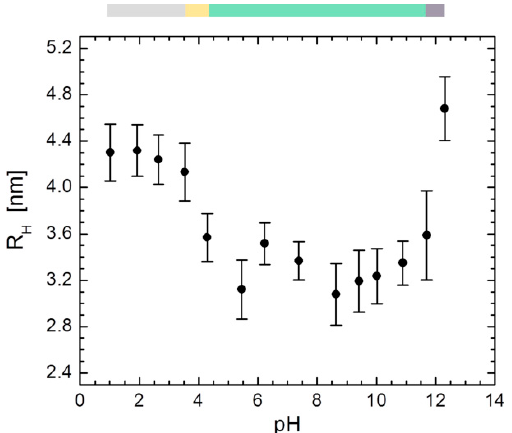
Figure 10. pH ‐ dependent DLS experiments on pure HSA. Hydrodynamic radii R H of HSA are given as a function of pH. The phase space bar gives the extended form (E, gray), compact form (C, green) and the aged form (A, purple) that can be clearly separated. A fast migrating form (F, yellow) is assumed to appear in a narrow range between pH 3.5 and 4.3.